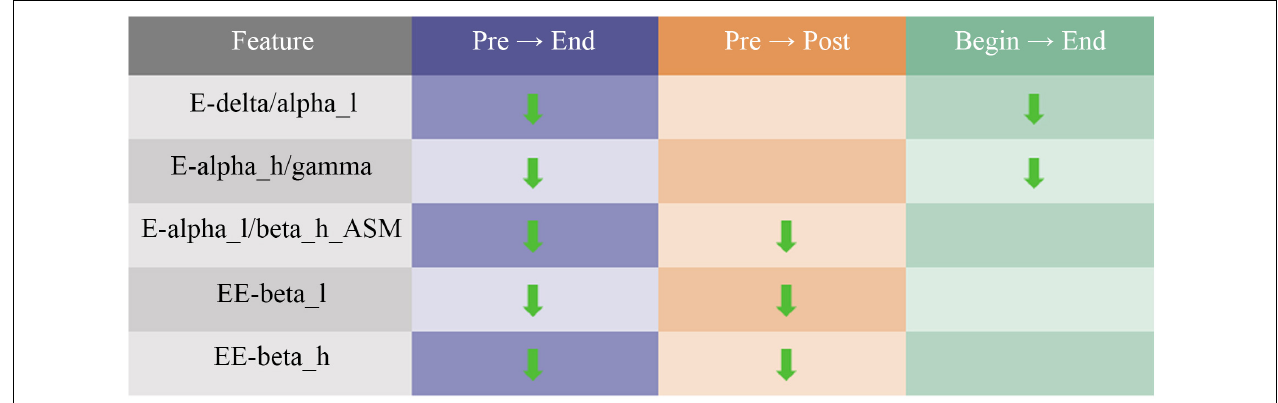
FIGURE 10 | Summary of changes in electroencephalogram (EEG) characteristics of patients with depression after the relaxation scenes.